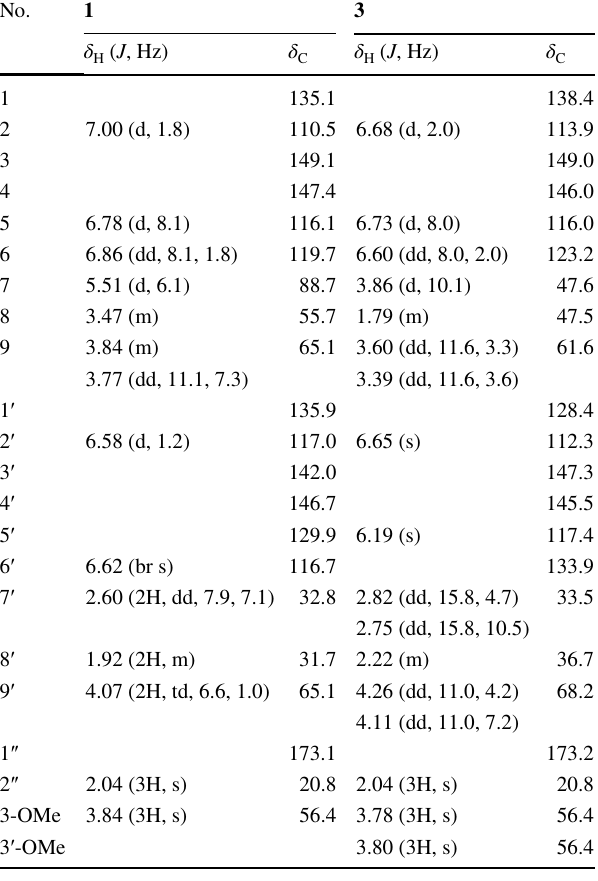
Table 1 1 H (800 MHz) and 13 C NMR (200 MHz) data of 1 and 3 in